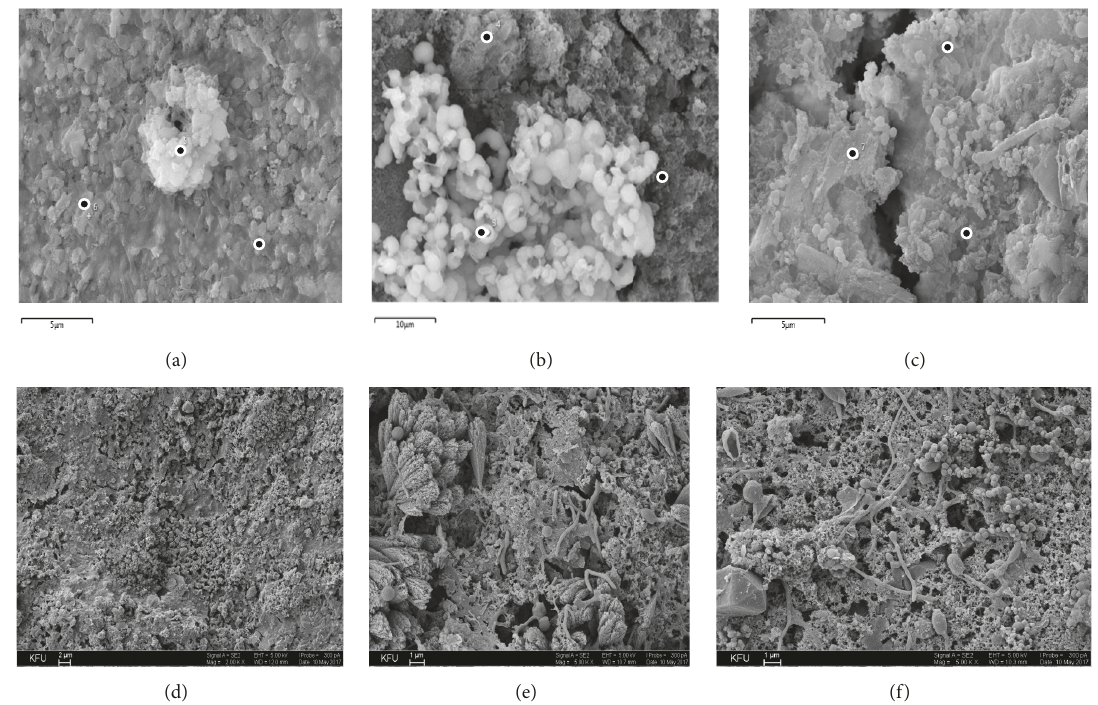
Figure 3: Visualization of M 600 concrete samples surface infected by P. brevicompactum P4 spores after 28 days of treatment. ( a, d ) Control samples without treatment; ( b, e ) fungal growth on the concrete surface which was completely immersed in the culture medium; ( c, f ) superficial growth on the concrete surface which was contacted with air in container. ( a-c ) Samples used for element composition testing, points show areas for analysis (Merlin scanning microscope, Carl Zeiss, Germany). ( a ) Illustration of chemical formation of calcite around the microcrack.